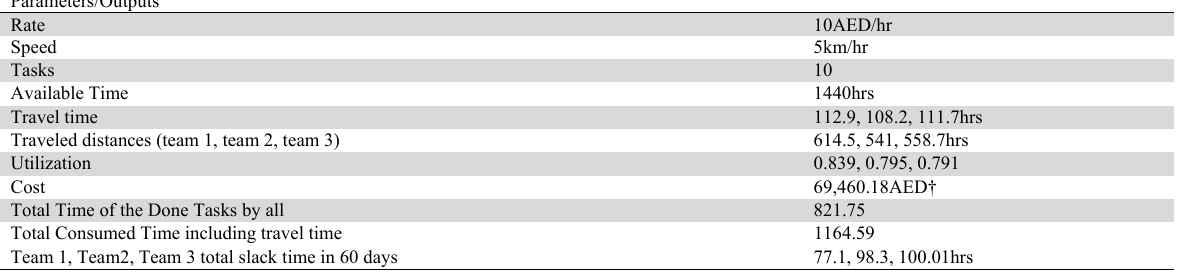
Results of 10 tasks and 60 days maintenance schedule Parameters/Outputs